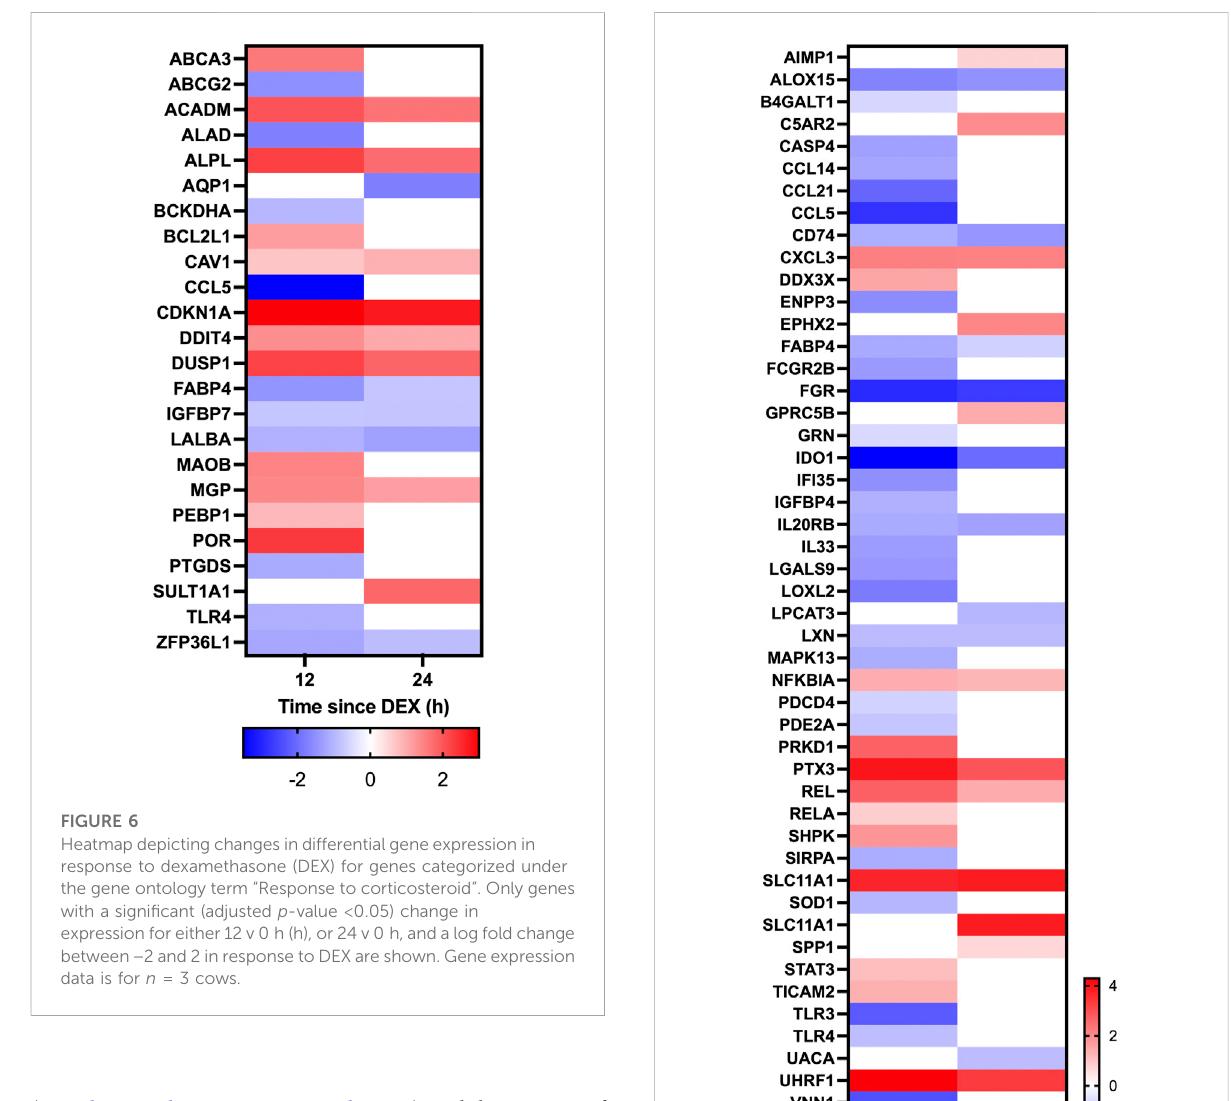
FIGURE 7 Heatmap depicting changes in differential gene expression in response to dexamethasone (DEX) for genes categorized under the gene ontology term “ In fl ammation. ” Only genes having a signi fi cant (adjusted p -value < .05) change in expression for either 12 v 0 h (h) or 24 v 0 h, and a log fold change between − 4and 4in response to DEXare shown. Geneexpression data is for n = 3